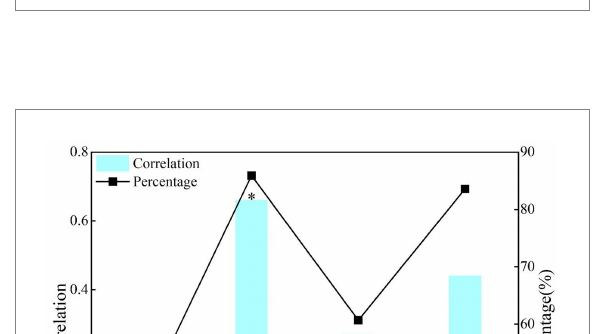
FIGURE 2 Correlations and area percentage of positive correlations between NDVI and SPEI at the same period effect of monthly scale. * p < 0.05, ** p < 0.01; the same below.